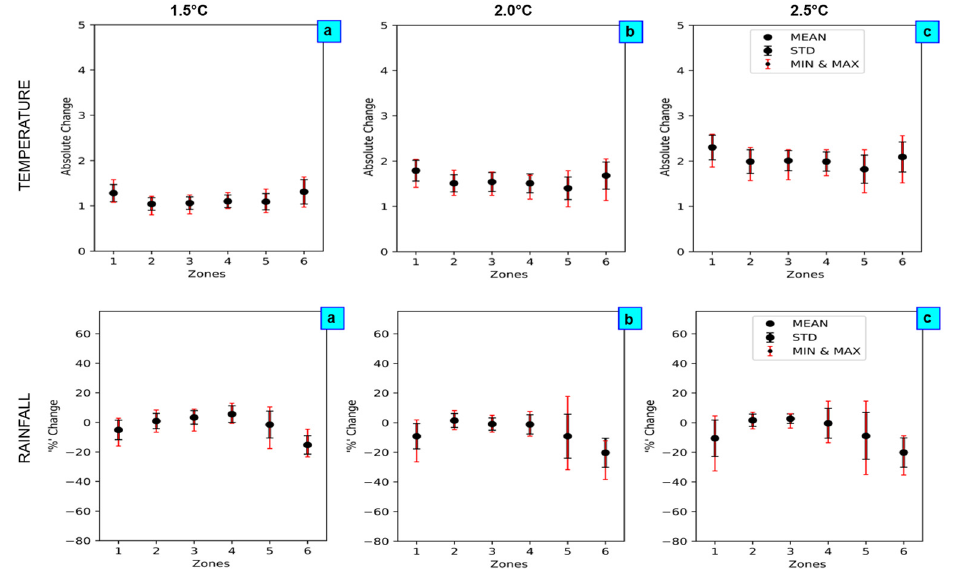
Figure 8. Graphs showing the absolute change in temperature (top row) and percentage change in rainfall (bottom row) with respect to a 1960–1990 baseline for each rainfall zone for ( a ) 1.5, ( b ) 2.0, and ( c ) 2.5 °C. Black dots represent the ensemble mean for the period, red whisker lines represent the ensemble minimum and maximum, and the black whisker represents the one standard deviation. Graphs are for the annual average.